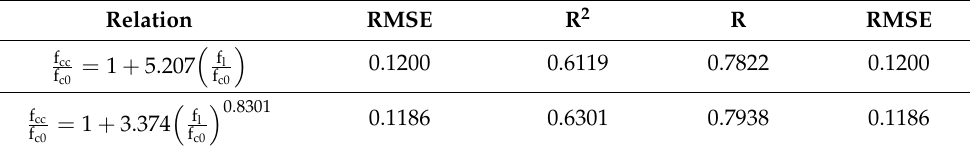
Table 3. Regression analysis results of Equation (2) and Equation (3).